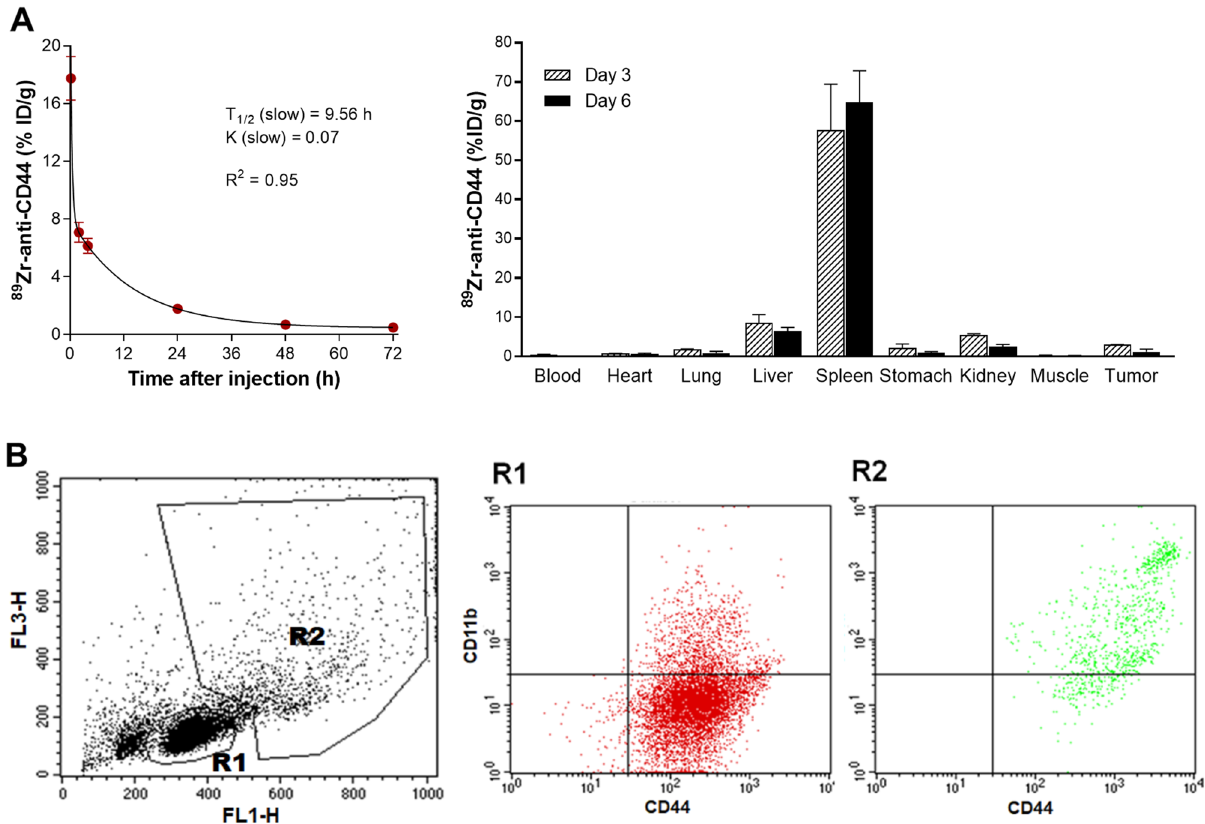
Figure 2. 89 Zr-anti-CD44 pharmacokinetics and biodistribution in mice, and CD44 expression on leukocytes from mouse spleen. ( A ) 89 Zr-anti-CD44 pharmacokinetics in normal Balb/c mice (n = 5) and biodistribution in SNU-C5 tumor-bearing Balb/c nude mice (n = 4) after intravenous injection. Data are mean ± S.D. of % ID/g. ( B ) CD44 and CD11b expression on leukocytes isolated from the spleen of a normal Balb/c mouse. Single- cell suspensions were obtained by mincing the spleen. Representative flow cytometry forward and side scatter analysis plots (left) demonstrate the R1 region that corresponds to lymphocytes and R2 region that corresponds to myeloid cells. Flow cytometry with FITC-anti-CD44 and APC-anti-CD11b (right) reveal that cells of the R2 region are CD11b + /CD44 +